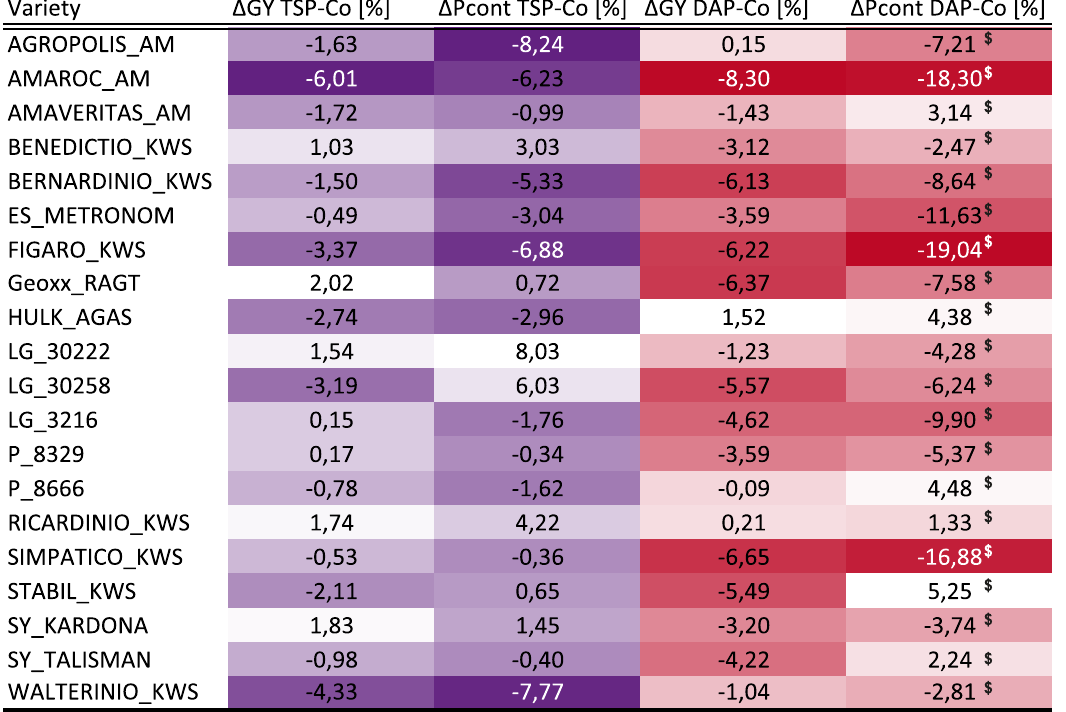
Fig 5. Relative differences for each hybrid variety. Grain yield (GY) and P content (Pcont) are based on best linear unbiased estimators (BLUEs) across locations between the fertilized treatment (purple: triple superphosphate (TSP); red: diammonium phosphate (DAP)) compared to the control. The darker the coloration, the stronger the